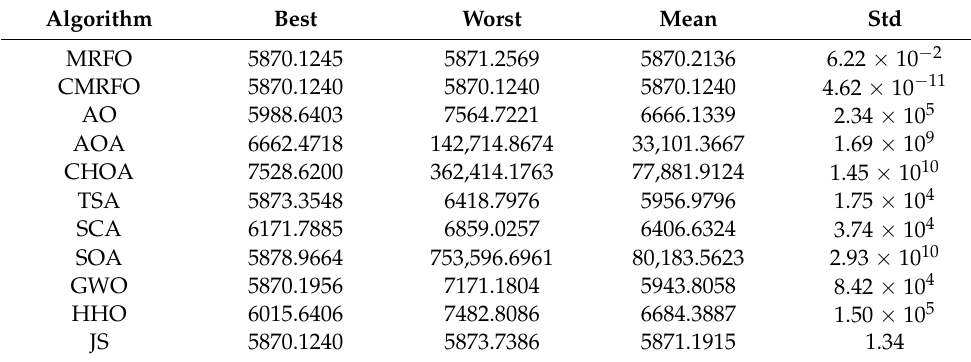
Table 11. Statistical analyses of all 11 algorithms after 30 runs.